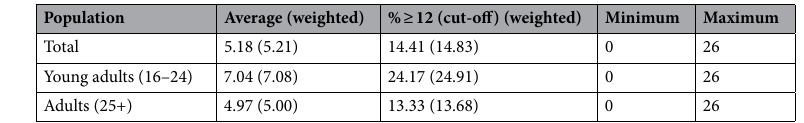
Table 2. SMFQ score for sample population, and by age groups (weighted and not weighted).